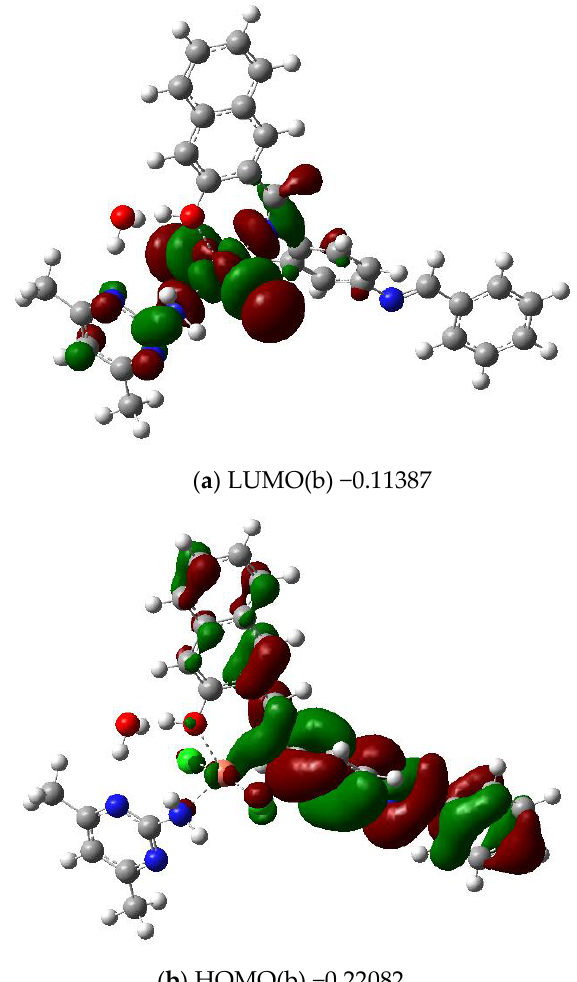
Figure 5. Frontier orbitals and their energies for the Cu(II) complex ( a , b ).